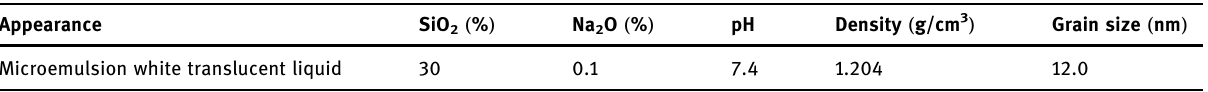
Table 6: Performance parameters of NS